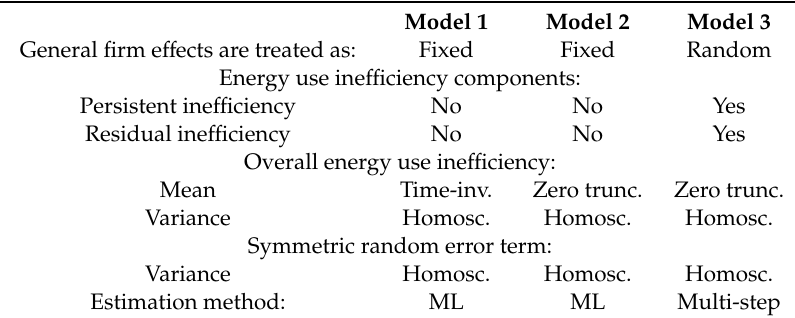
Table 1. Main characteristics of the di ff erent